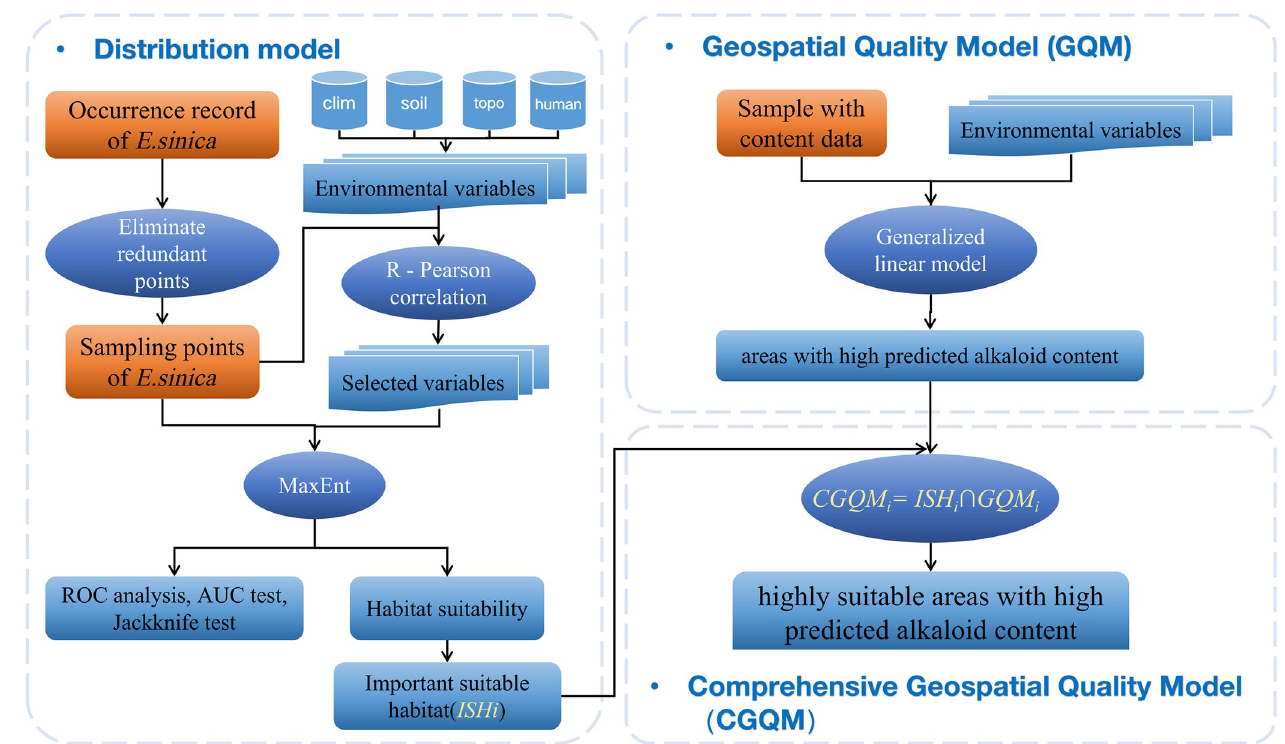
Fig 2. Schematic representation of the implemented methodological